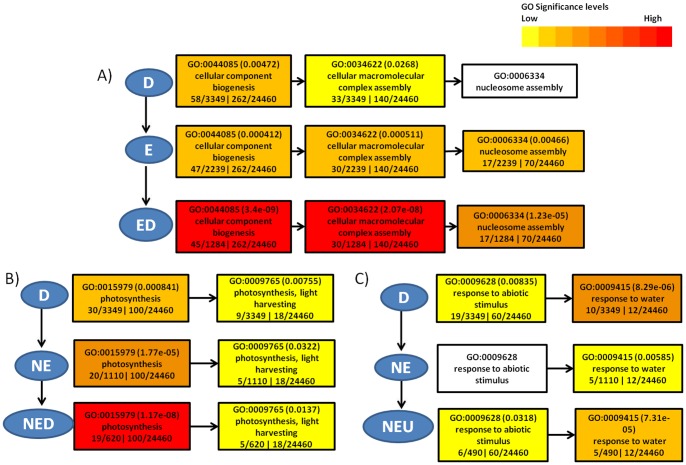
Examples of enrichment/depletion of significant GO terms in DRG clusters.A) and B) show increase and C) shows decrease in the significance of GO terms as we move to sub clusters indicated by vertical arrows. Also shown are the changes in significance of GO terms from a parent to child GO term indicated by horizontal arrows. White boxes denote GO terms that are not significant (p>0.05).